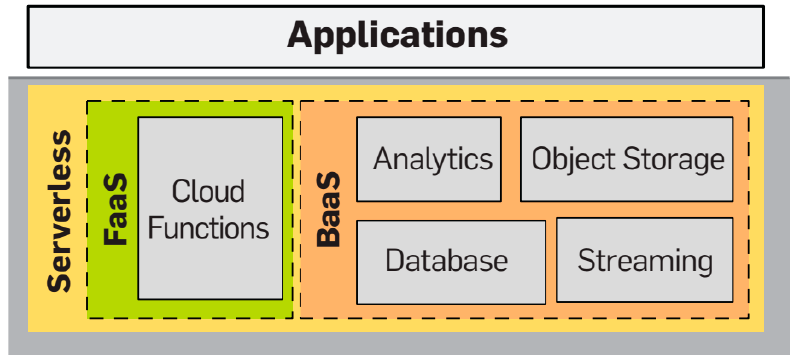
Figure 2. Illustration of application-specific serverless computing [65].